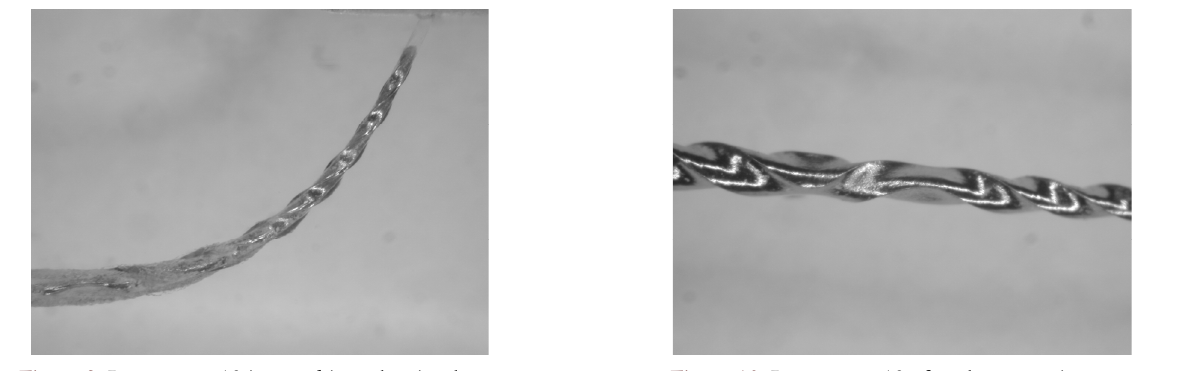
Figure 9: Instrument 13 inserted into the simulator. Figure 10: Instrument 13 after the extraction test.